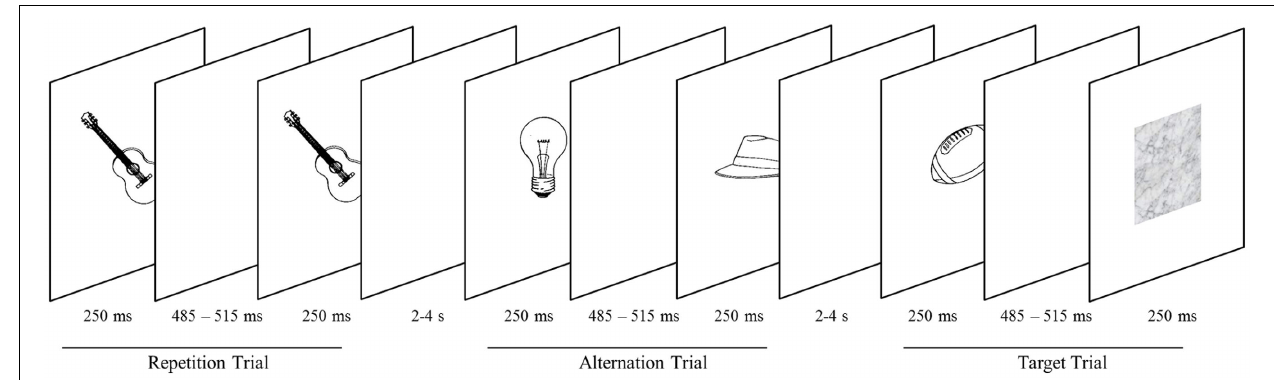
FIGURE 1 | Objects are presented in successive pairs separated by a blank screen. Pairs either comprise the same object (repetition trials) or two different objects (alternation trial). Subjects screen stimuli for blurred objects